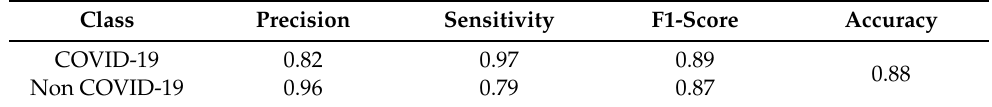
Table 6. Best Hyperparameters Configuration